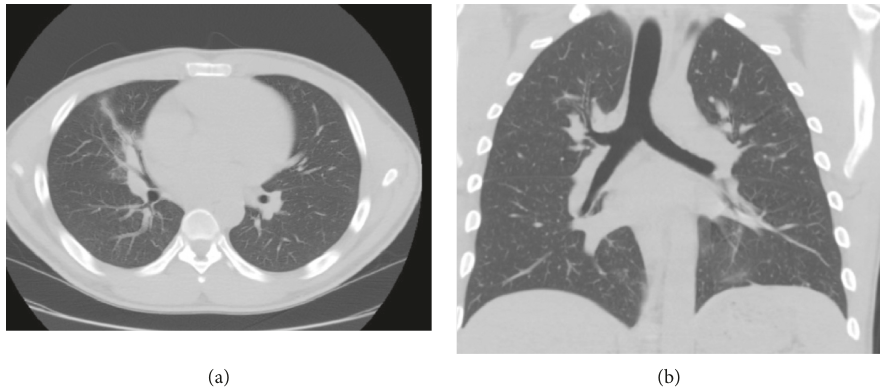
Figure 3: (a) CT chest (axial view) three months after initiation of treatment showing near-complete resolution of the right middle lobe infiltrate. (b) CT chest (coronal view) three months after initiation of treatment.